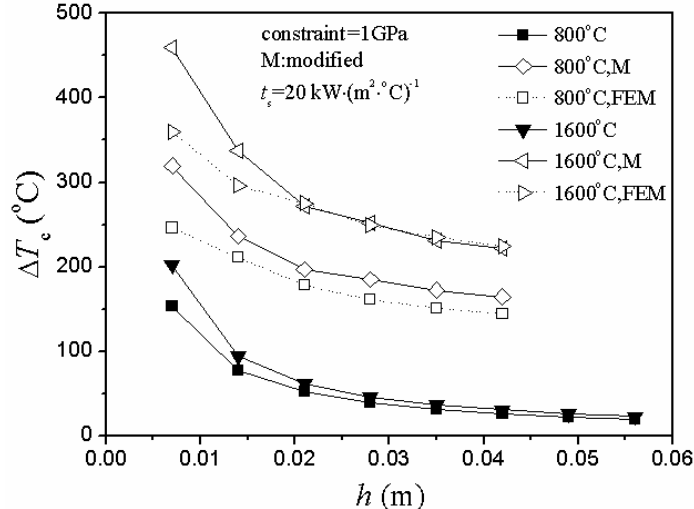
Figure 4. Relationship between critical rupture temperature difference, ∆ T thickness, h , including modified, unmodified and numerical simulation situations under different initial thermal shock temperature of temperature elevated conditions (FEM represents finite element method).